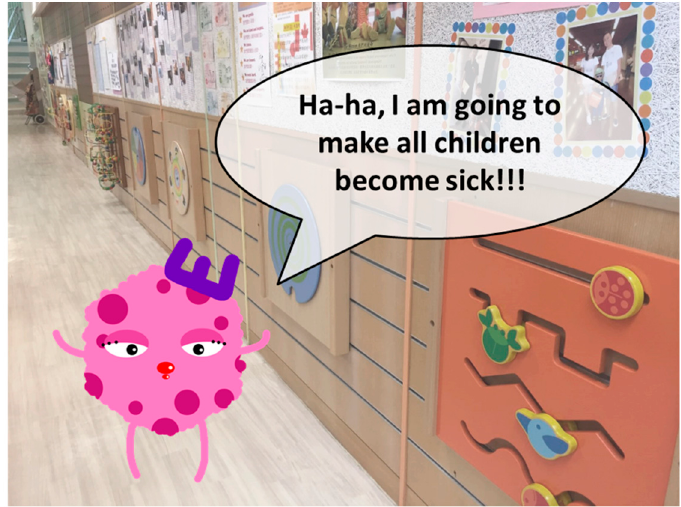
Figure 2. Screenshot of the animated video.